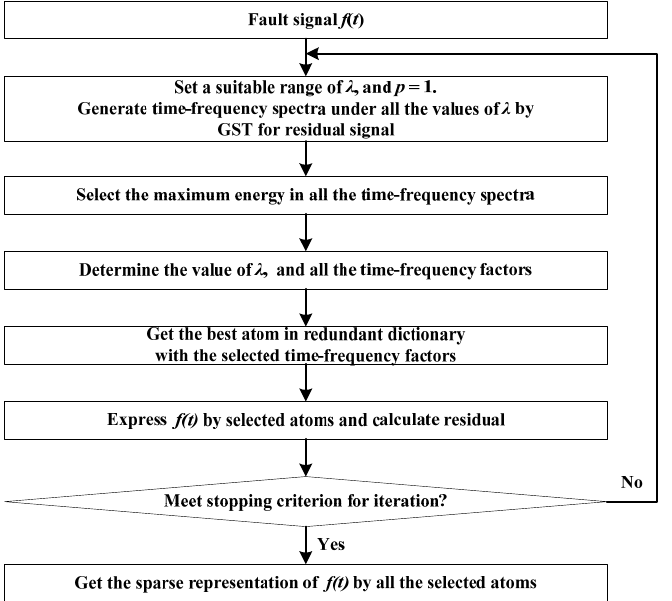
Figure 1.T he flow of sparse decomposition based on a multi ‐ resolution GST time–frequency spec ‐ Figure 1. The flow of sparse decomposition based on a multi-resolution GST time–frequency trum. Realization of this method includes four steps: generation of all time–frequency spectra by GST, determination of optimal time–frequency factors, construction of optimal atoms by selected optimal time–frequency factors, and sparse representation using se ‐ lected atoms.